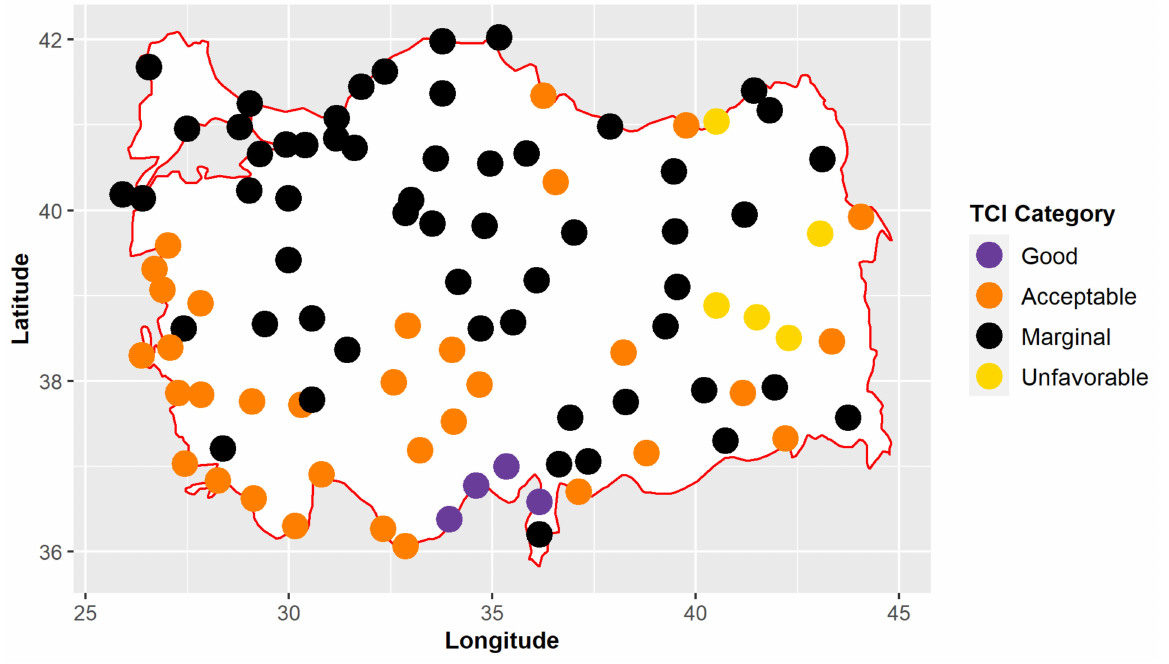
Figure 2. The TCI distribution for